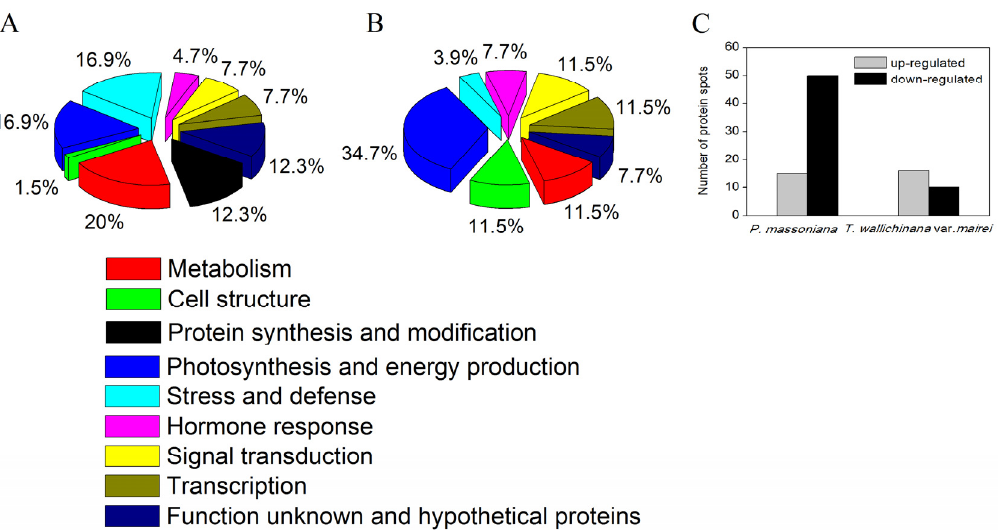
Figure 3. Functional category distribution of the identified proteins in P. massoniana and T. wallichinana var. mairei under the AR treatment. Each identified protein listed in Tables 1 and 2 was functionally classified based on their known and putative functions. functional category. ( A ) AR-responsive proteins in P. massoniana ; ( B ) AR-responsive proteins in T. wallichinana var. mairei ; ( C ) Number of protein spots significantly up-regulated